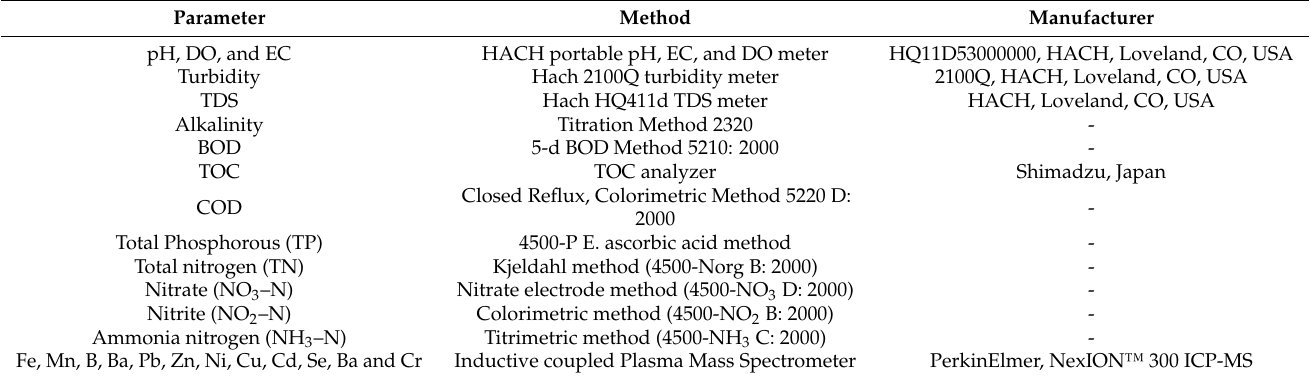
Table 2. Laboratory methods used in water quality analysis of the